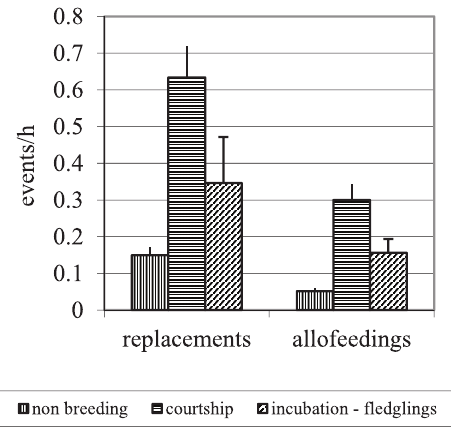
Figure 10. Effect of the social phase on replacements/h and allofeedings/h of M